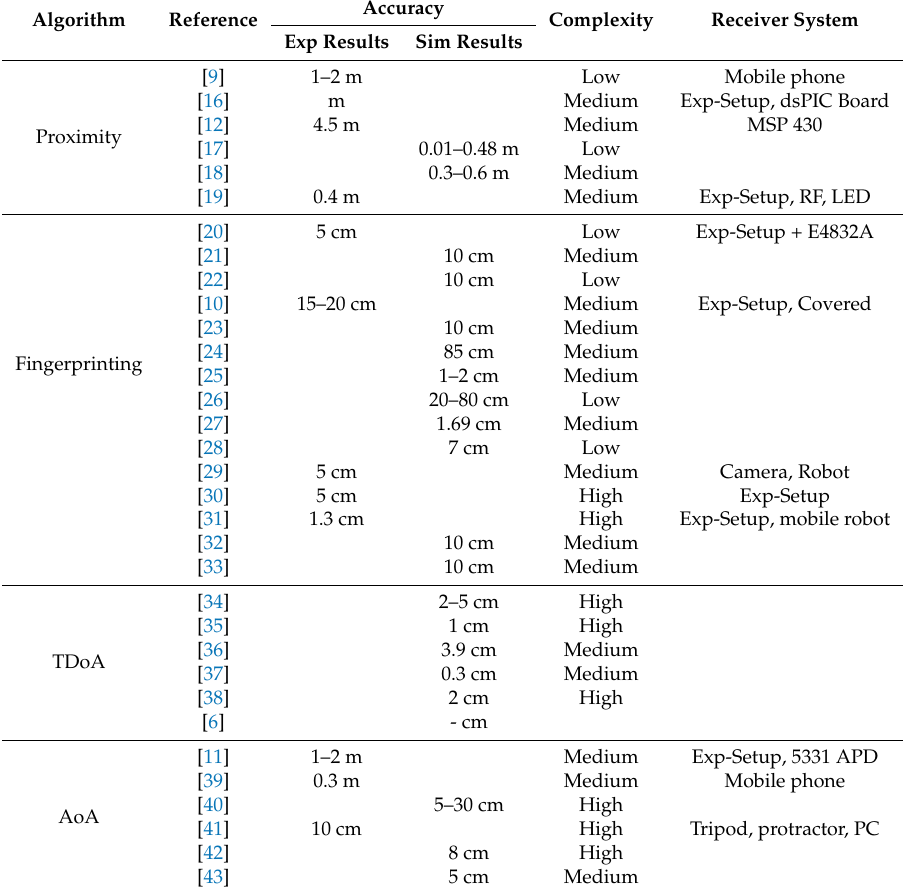
Table 1. Summary of light emitting diode (LED)-based positioning techniques. Adapted from [15]. Exp: Experimental, Sim: Simulation, APD: Avalanche